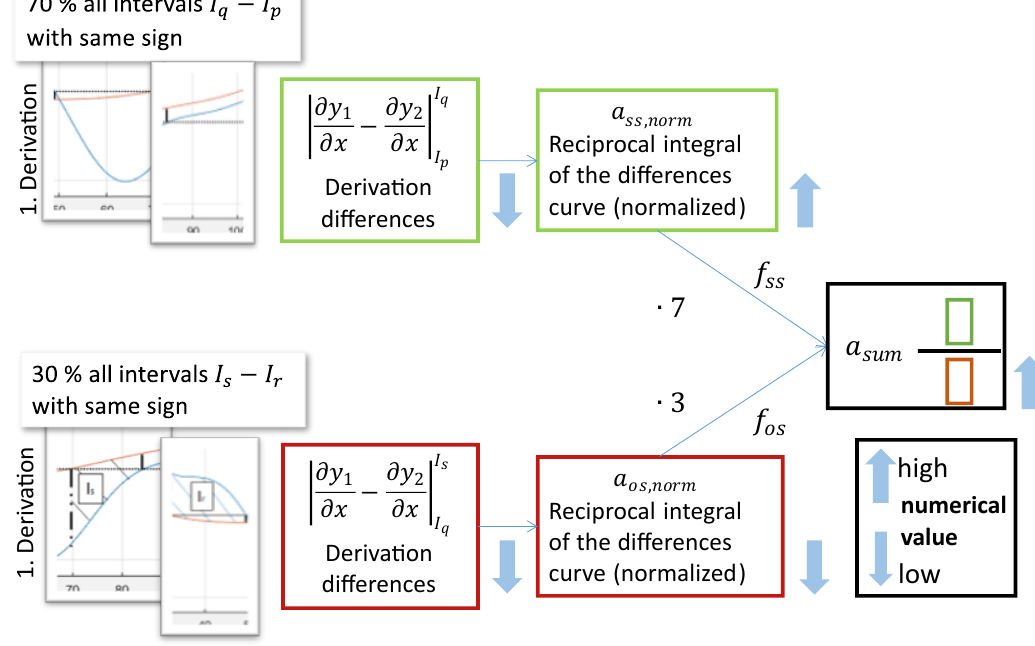
Figure 5. Diagram illustrating the calculation of congruence to determine the particle size of a fitted curve from the simulation